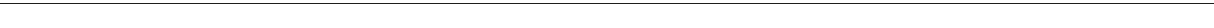
Fig. 4 MAPL-mediated sumoylation of NLRP3 suppresses in fl ammasome activation. a Depletion of MAPL reduces the association between NLRP3 and SUMO-2/-3 and increases the interaction between NLRP3 and ASC. Immortalized WT BMDMs were transfected with non-targeting or Mapl -speci fi c siRNAs. After 48 h, cells were left untreated, primed with LPS for 4 h or treated with LPS (4 h) followed by 30 min with nigericin. PLA was performed using α -NLRP3 and either α -MAPL (upper panel), α -SUMO-2/-3 (middle panel) or α -ASC antibodies (lower panel), as indicated. Representative confocal microscopy images are shown for each condition. Scale bar, 10 µ m. The number of fl uorescent spots per cell was quanti fi ed for 50 cells. The average of duplicate counts is represented on the right-hand side of the microscopy images. Circles represent individual data points and error bars represent ±SD. Data were analysed using two-way ANOVA multiple comparison test ** P < 0.01, *** P < 0.001. b Schematic diagram of the experimental procedure performed in c . c Activation and release of caspase-1 under the indicated conditions was evaluated by western blot. N1-8 macrophages were transfected with non-targeting or Mapl -speci fi c siRNAs and primed with LPS (10 min for caspase-1 or 4 h for IL-1 β ). Cells were subsequently stimulated with nigericin or cytoplasmic DNA. Cleaved caspase-1 (p20 band) was quanti fi ed using Image Lab Software (Bio-Rad). d IL-1 β levels in the cell supernatant were measured by enzyme-linked immunosorbent assay (ELISA). Individual data points (circles) of three independent experiments are presented as fold change compared to Ctrl N1-8 BMDMs (non-targeting siRNA). Grey bar is the mean ± SEM. ** P < 0.01; two-tailed Student ’ s t -test on log2-transformed data comparing nigericin treated BMDMs transfected with Mapl -speci fi c siRNA to Ctrl